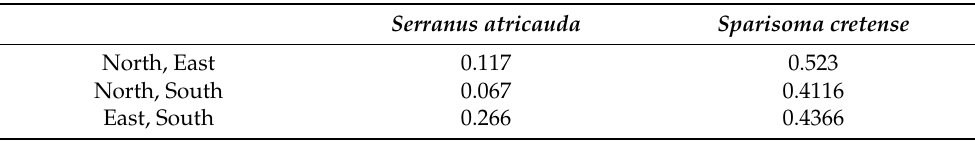
Table 3. Results of the two-way PERMANOVA analyzing the variation in the content of heavy metals and trace elements in muscle tissue in species according to study zone, considering the level of the factor